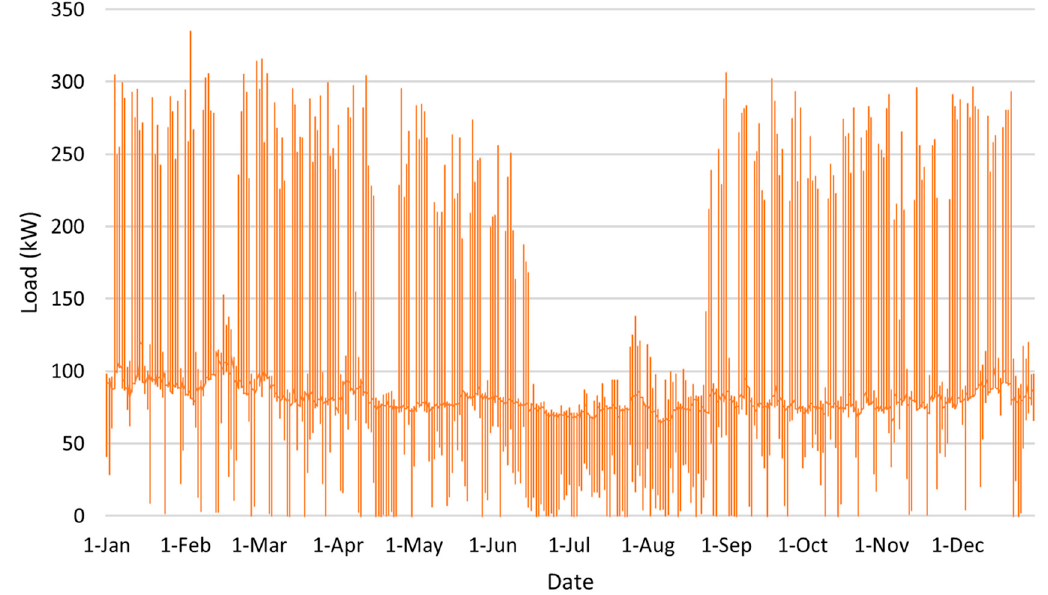
Figure 3. SVAHS hourly peak load, 2016.